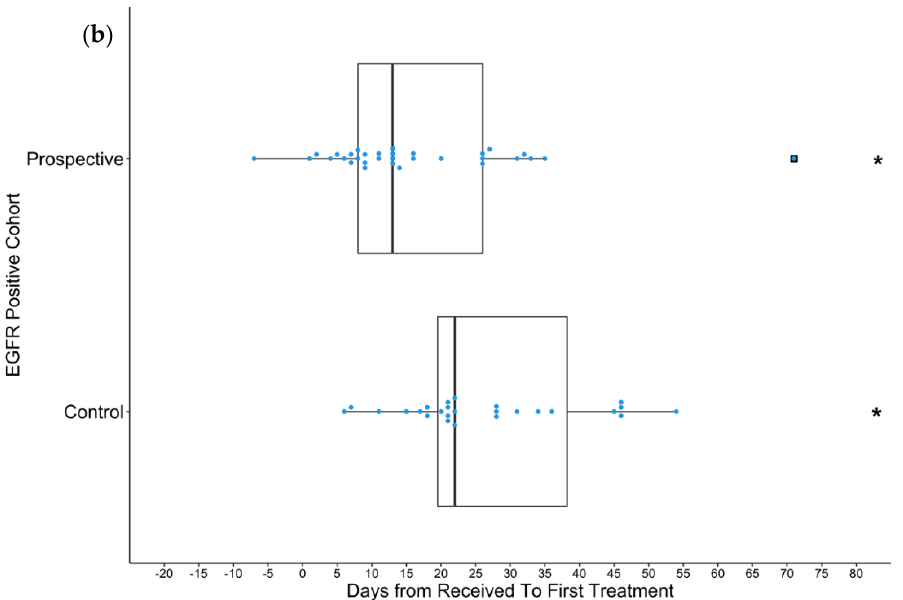
Figure 2. Boxplots visualize median, two hinges (25% and 75% quantiles), and two whiskers (95% CI). Black squares indicate outliers. Each blue dot represents an individual at a certain time-point. ( a ) The distribution of TTT of all patients in the control (N = 114) and trial (N = 114) cohorts who were included in TTT analysis. For the prospective trial cohort, the mean and median are 30.7 and 26 days, respectively. For the control cohort, the mean and median are 40.8 and 32 days, respectively. The difference in means is − 10.1 days ( p = 0.013, 95% CI: [ − 17.9, − 2.2] days). ( b ) Distribution of TTT in patients who were treated based on EGFR positivity in the control (N = 28) and trial (N = 33) cohorts. For the prospective trial cohort, the mean and median are 18.5 and 13 days, respectively. For the control cohort, the mean and median are 35.3 and 22 days, respectively. Difference in means is − 16.8 days ( p = 0.03, 95% CI: [ − 32.1, − 1.5] days). Asterisks indicate histograms with excluded data points.